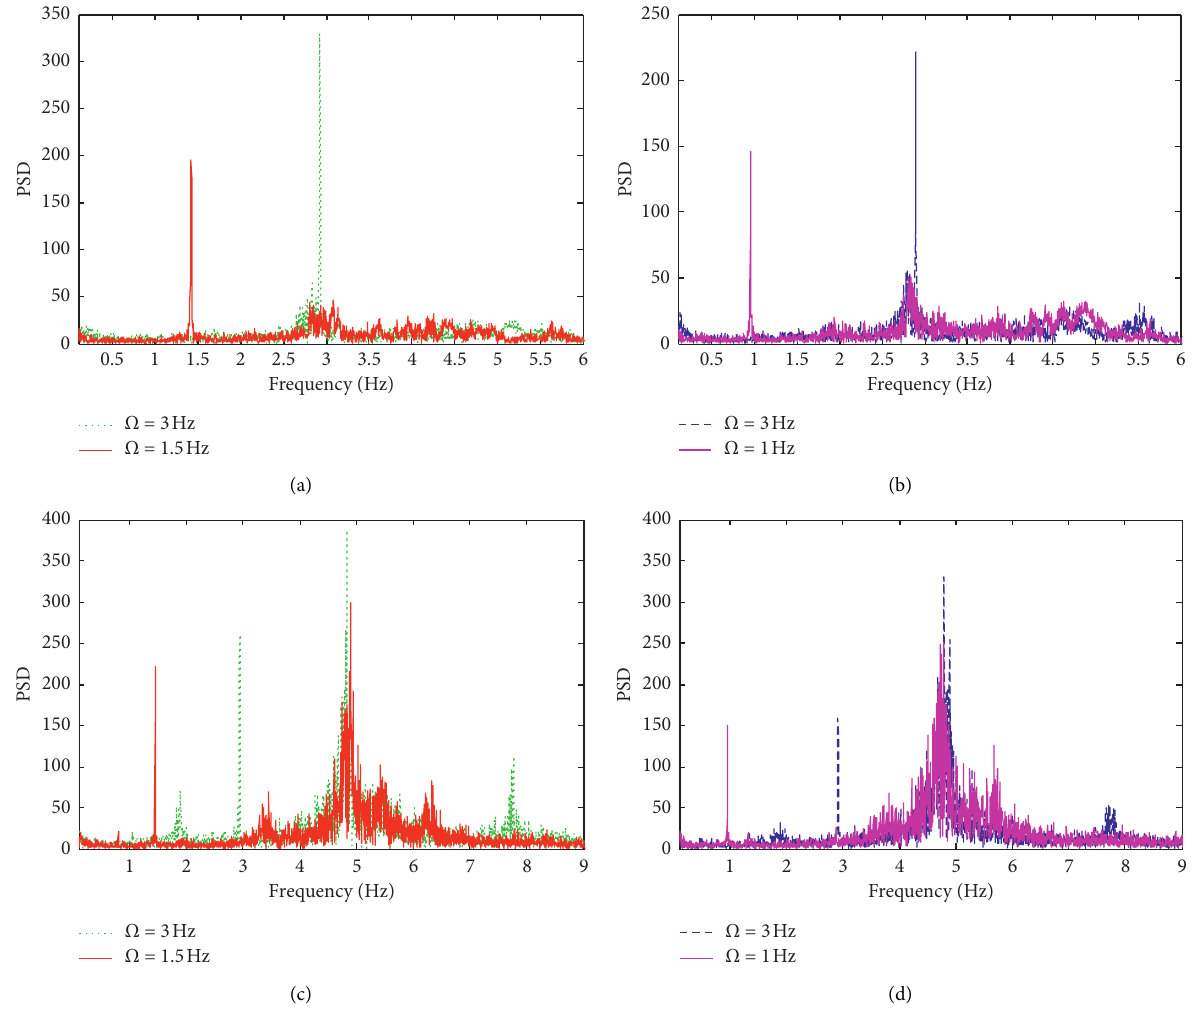
Figure 14: Frequency spectrum of TTR: (a) U � 0.3m/s, T � 100N, and △ T � 30 N; (b) U � 0.3m/s, T � 100N, and △ T � 20N; (c) U � 0.5 m/ s, T � 100 N, and △ T � 30N; (d) U � 0.5m/s, T � 100N, and △ T �